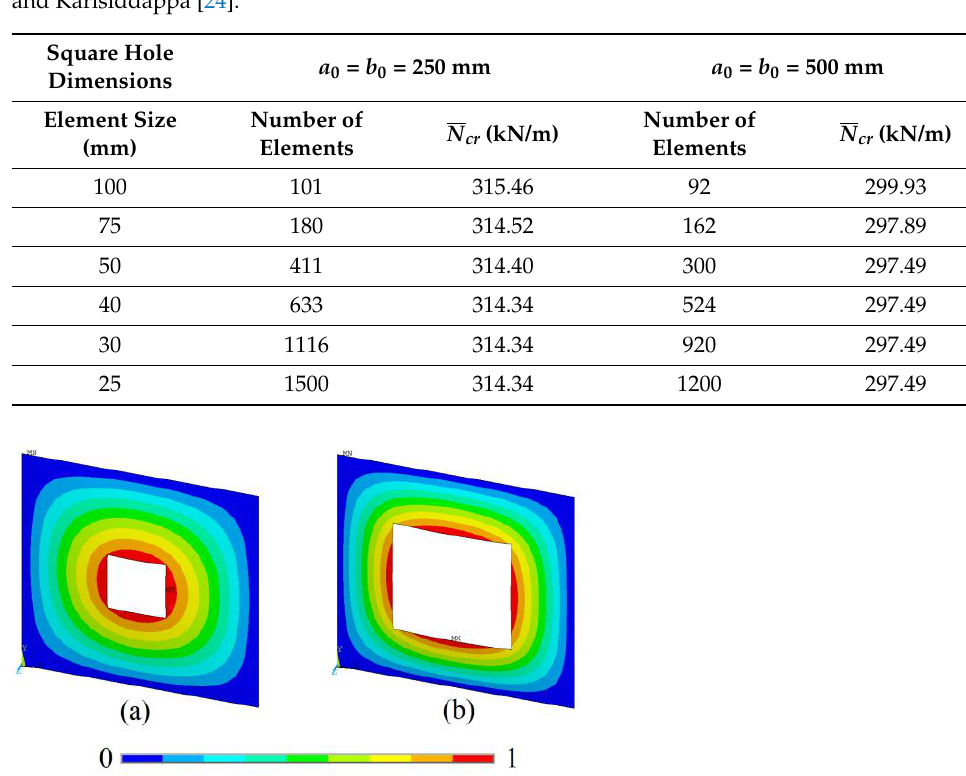
Figure 5. Out-of-plane displacement due to the biaxial elastic buckling for the plate with square hole of ( a ) 250 mm and ( b ) 500 mm side. of ( a ) 250 mm and ( b ) 500 mm